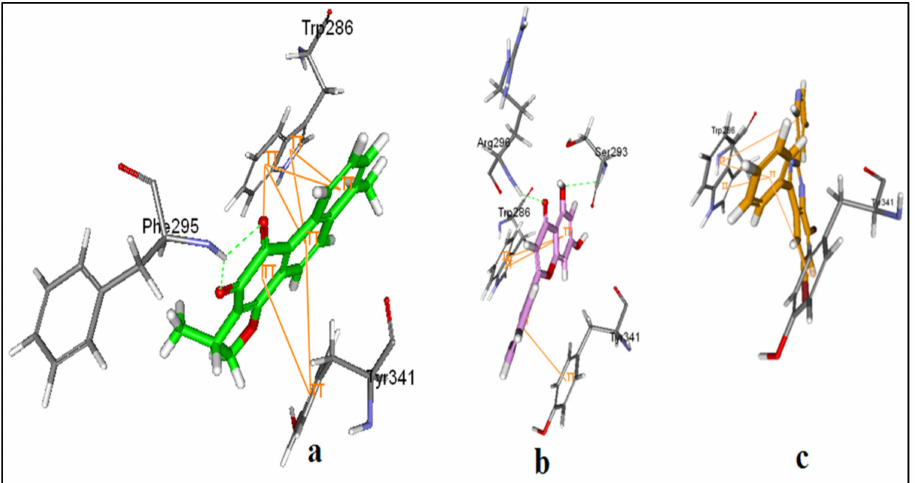
Figure 6. The 3D binding mode of DHI ( a ), 5,7-dihydroxy-2-phenyl-4H-chrome-4-one ( b ) and 4- phenyl-2-(pyridin-3-yl)quinazoline ( c ) showing π - π interactions as orange lines and hydrogen bonds as green dotted lines with the interacting amino acids (the rest of the binding site amino acids are hidden for